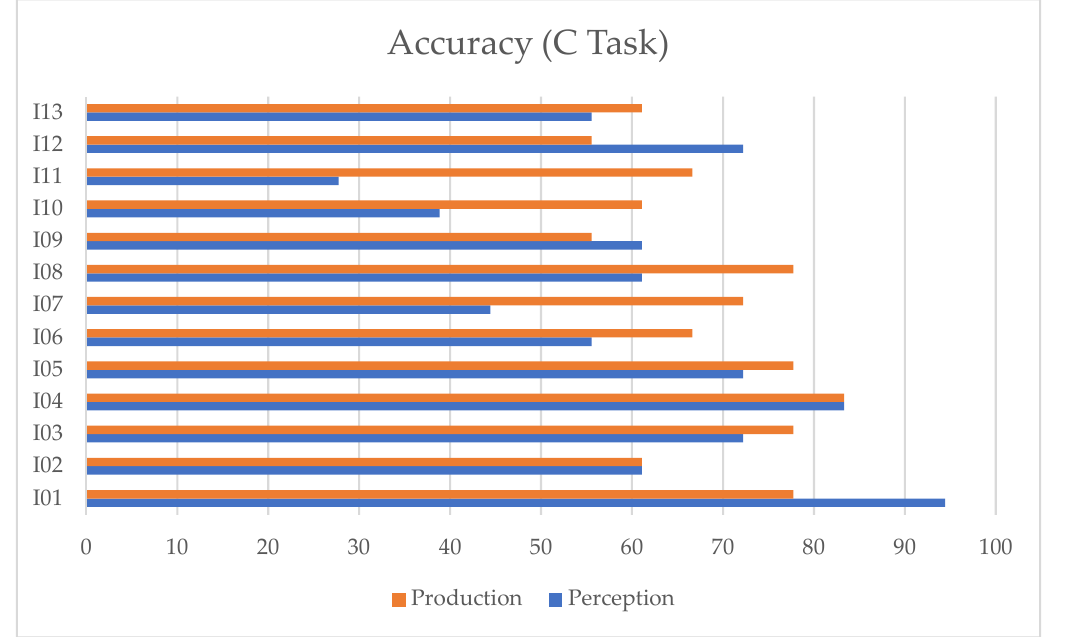
Figure 6. Accuracy in perception and production (C task only) by participant.